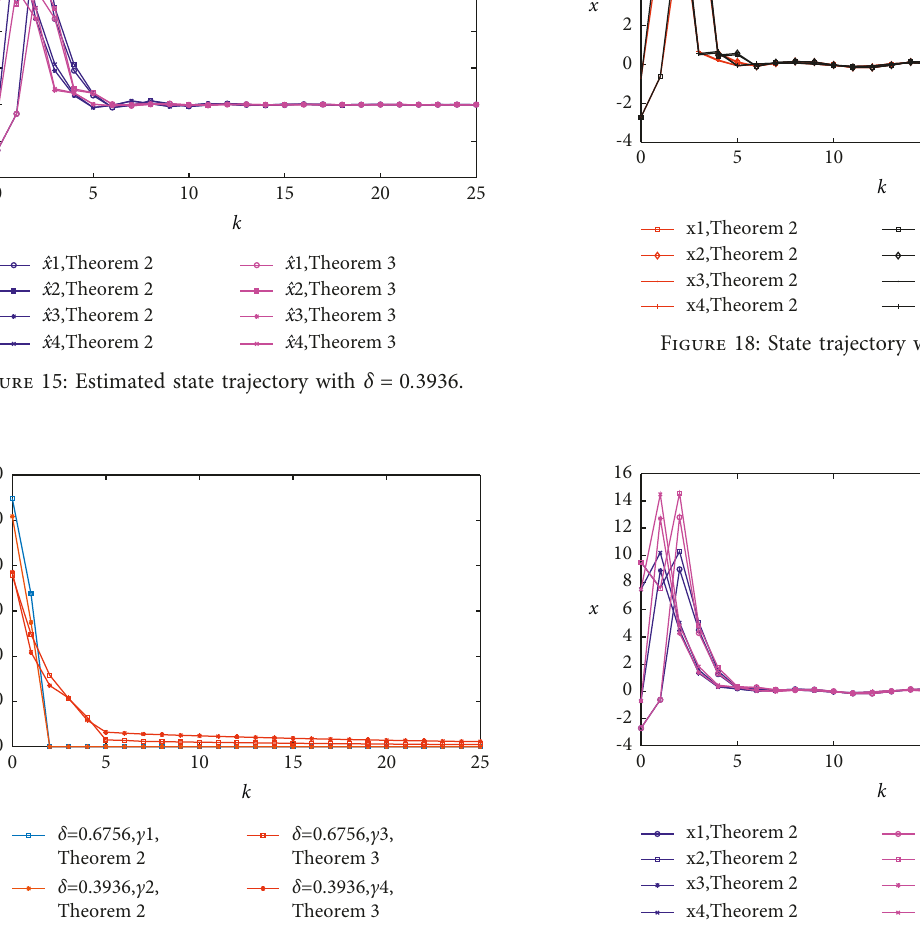
Figure 16: c ( k ) trajectory.